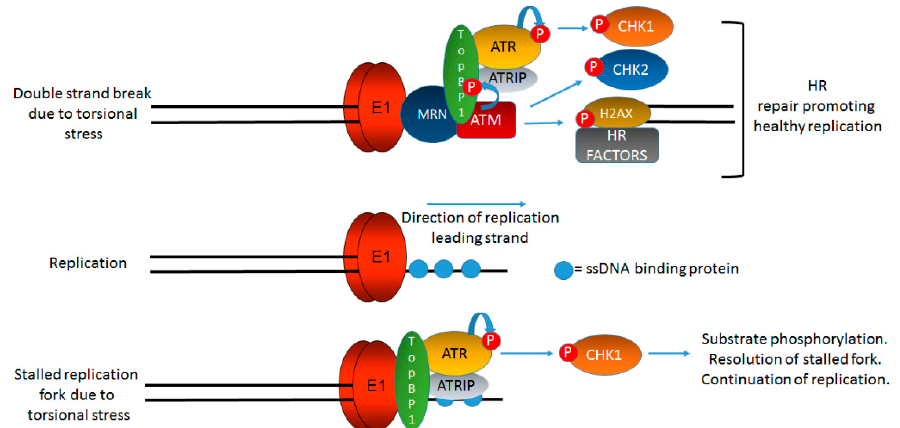
Figure 3. TopBP1 is a key protein initiating and coordinating DDR signaling at HPV replication centers. Figure 1 indicates that onion skin DNA replication can be formed on HPV genomes during